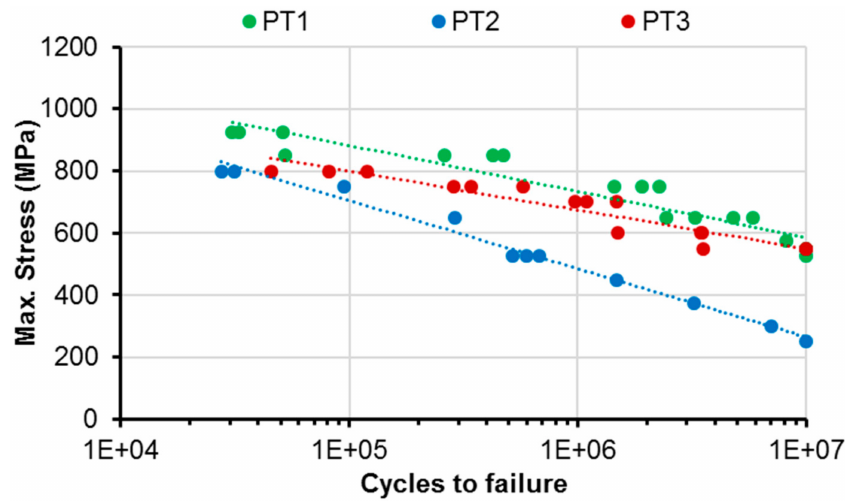
Figure 11. S-N curves after the PT1, PT2, and PT3 post-treatments.